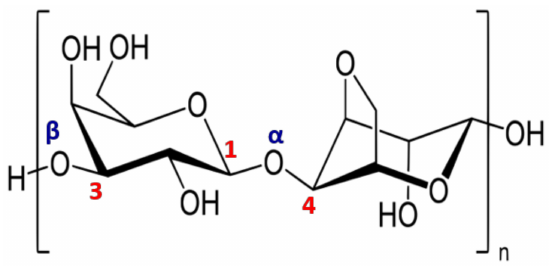
Figure 9. Representation of agarose.